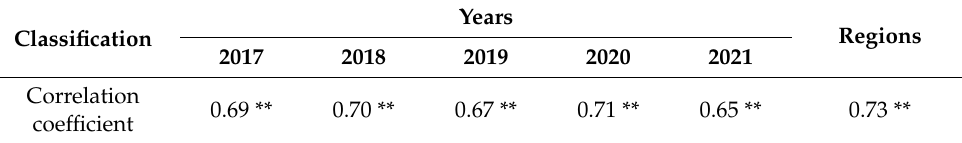
Table 7. The correlation between regional GDP and overall